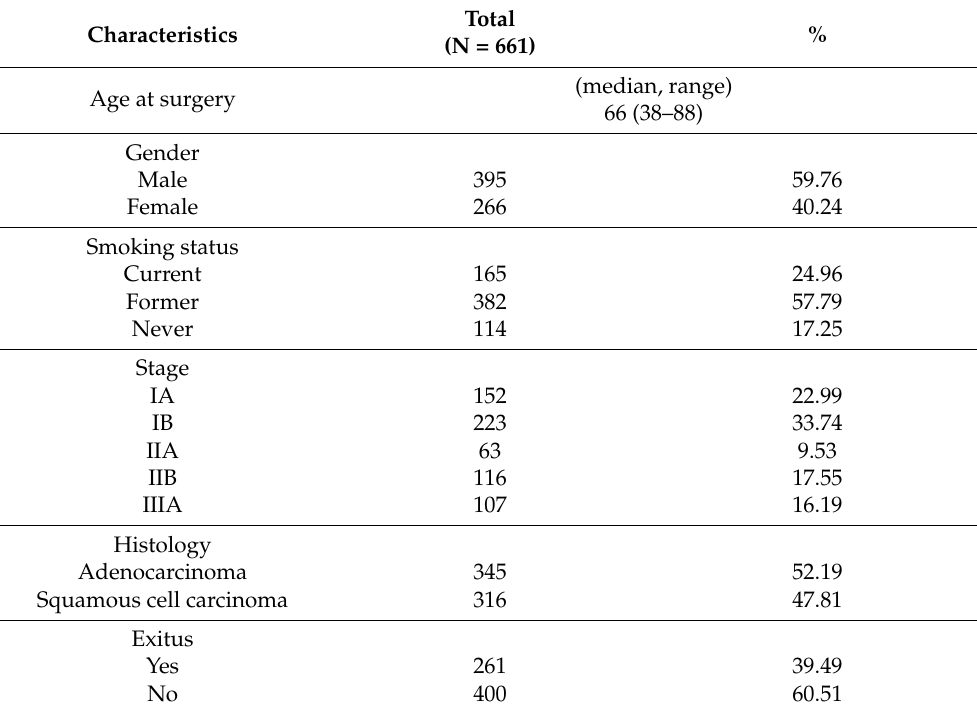
Table 2. Clinicopathological characteristics of the patients included in the in silico cohort (TCGA database).